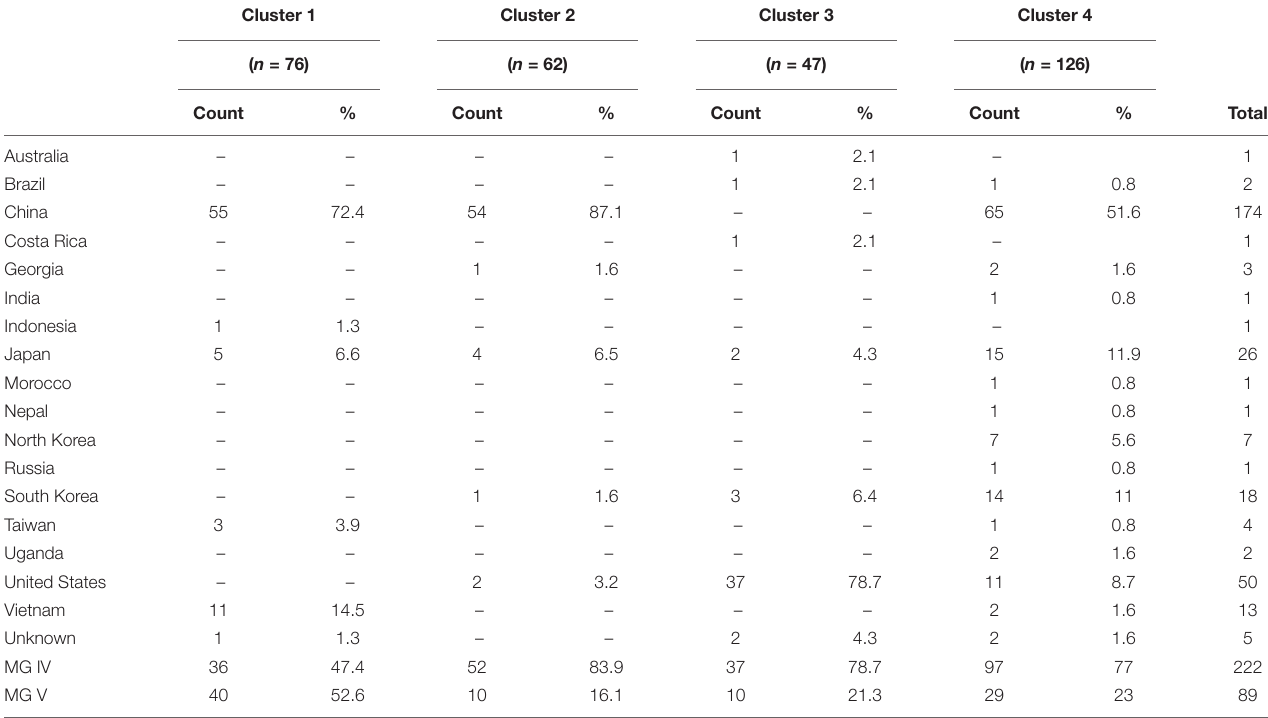
TABLE 1 | Countries of origin and maturity groups (MG) for clustered accessions as determined by discriminant analysis of principal components (DAPC). Cluster